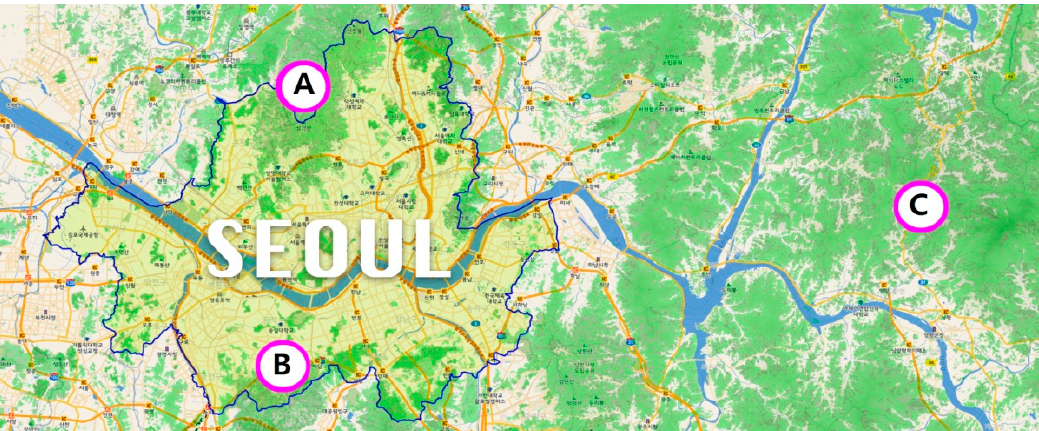
Figure 1. Research sites located in the suburbs of Seoul. ( A ) Mt. Gwanak Urban Forest; ( B ) Mt. Bukhan National Park; ( C ) Mt. Yumyeong Recreation Forest (https://map.forest.go.kr/forest/#/) (accessed on 7 June 2021). Table 1. Study area.